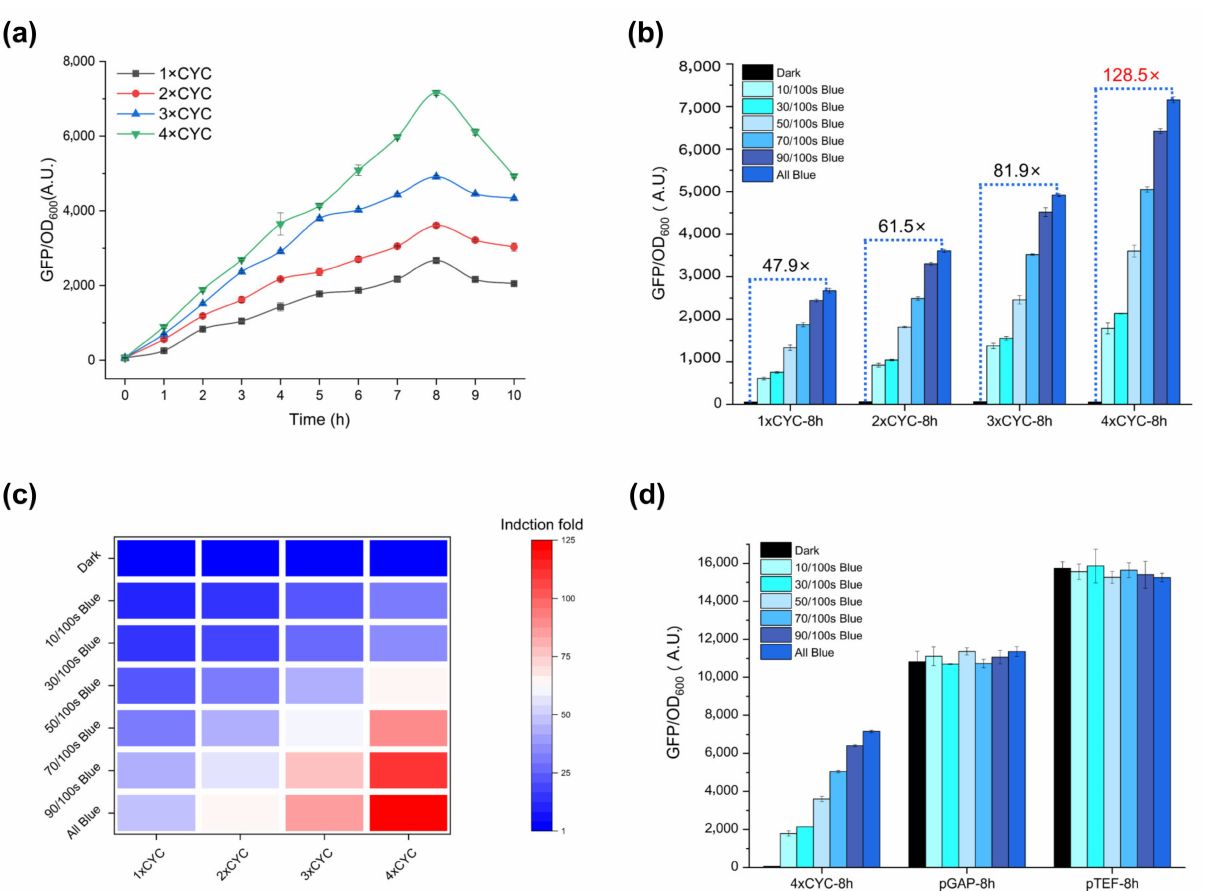
Figure 3. Dose-dependent activation. ( a ) 1~4 × CYC pYLBI circuits induced under constant blue light for 10 h. All groups reached the maximum fluorescence intensity after 8-h induction. ( b ) The Po1g harboring 1~4 × CYC pYLBI plasmids were induced for 8 h under a series of blue illumination conditions. ( c ) Dose-dependent activation with different illumination pulse and CYC copies after 8-h induction. ( d ) FI of 4 × CYC, pGAP and pTEF incubated under different periodic blue light conditions for 8 h. Under all-blue culture conditions, 4 × CYC can reach 66% ± 3% of pGAP level and 45% ± 1% of pTEF level. Error bars indicate Means ± S.D. (n =